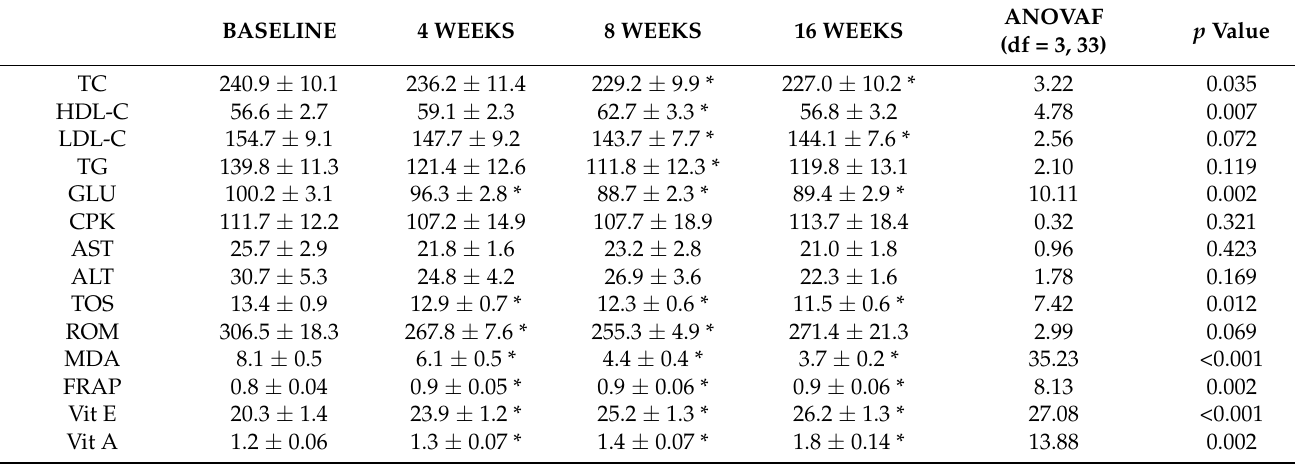
Table 2. Blood parameters of 12 volunteers at baseline and after 4, 8 and 16 weeks of Lippia citriodora extract treatment.